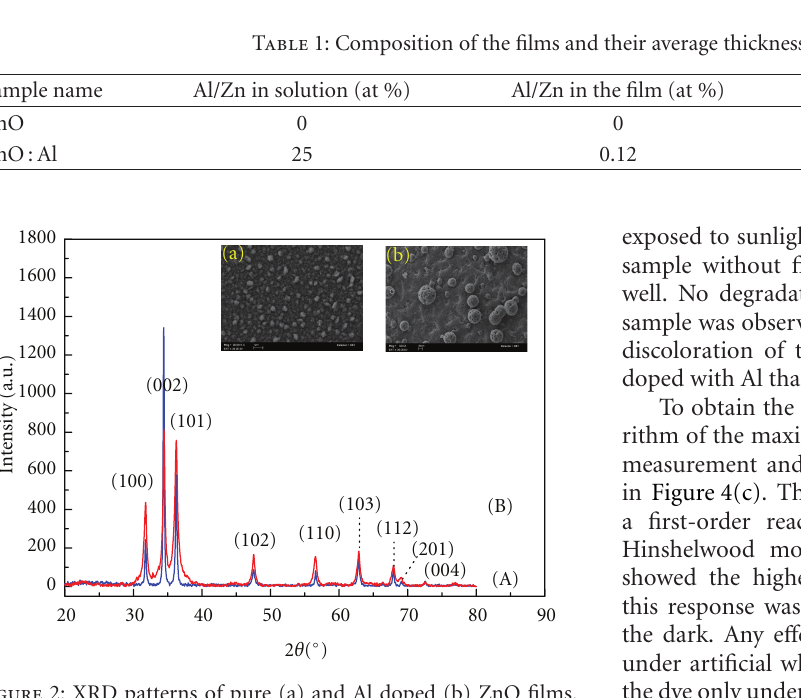
Figure 2: XRD patterns of pure (a) and Al doped (b) ZnO films. The insert shows the SEM images of their corresponding surfaces.